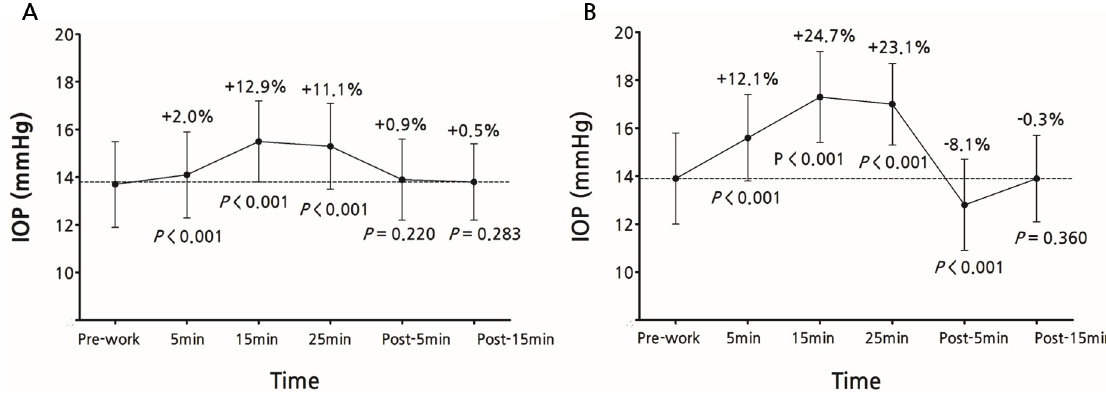
Fig 4. Mean intraocular pressure (IOP) of 39 eyes during and after smartphone work under daylight (A) and low-light (B) conditions. Daylight condition: mean IOPs significantly rose after 5 minutes of smartphone work ( P < 0.001), and were sustained until 25 minutes of smartphone use ( P < 0.001); within 5 minutes after stopping the smartphone work, the IOP returned to the pre-work level. Low-light condition: mean IOPs were elevated during 5, 15 and 25 minutes of smartphone work ( P < 0.001 at all points); 5 minutes after stopping the smartphone work, the IOP dropped below the pre-work level ( P < 0.001); 15 minutes after the work cessation, the IOP returned to the pre- work level. Note that the X-axis is not to scale but depicts the times at which the IOPs were measured during and after the smartphone work. The Y error bars indicate the standard error of the mean.